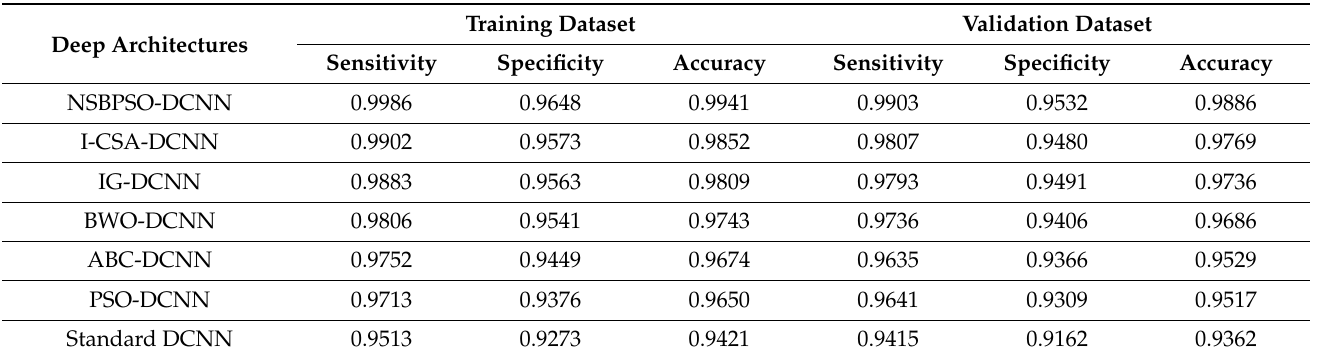
Figure 7. The confusion matrix. Table 3. The results of the proposed algorithms for intrusion detection in IoT systems.